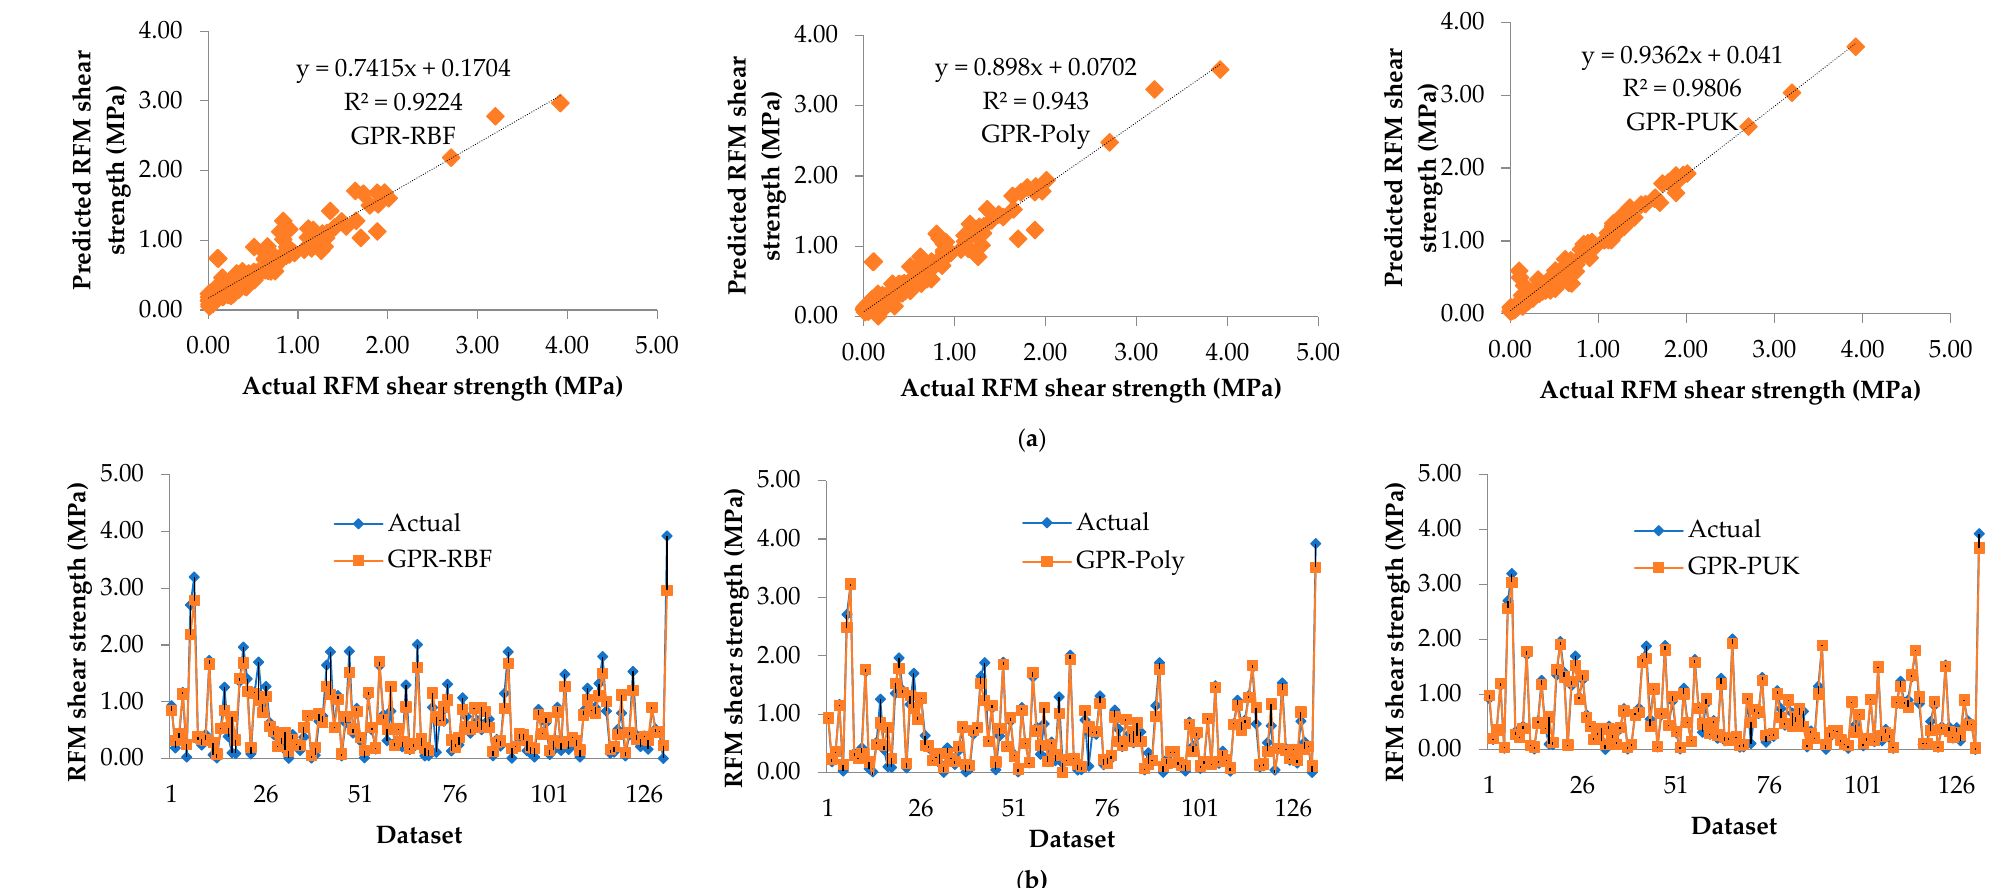
Figure 2. Comparison of the results in the training dataset of the various kernel function-based Gaussian process regression (GPR) models ( a ) measured vs. predicted RFM shear strength, ( b ) showing the accuracy of the models in predicting RFM shear strength.